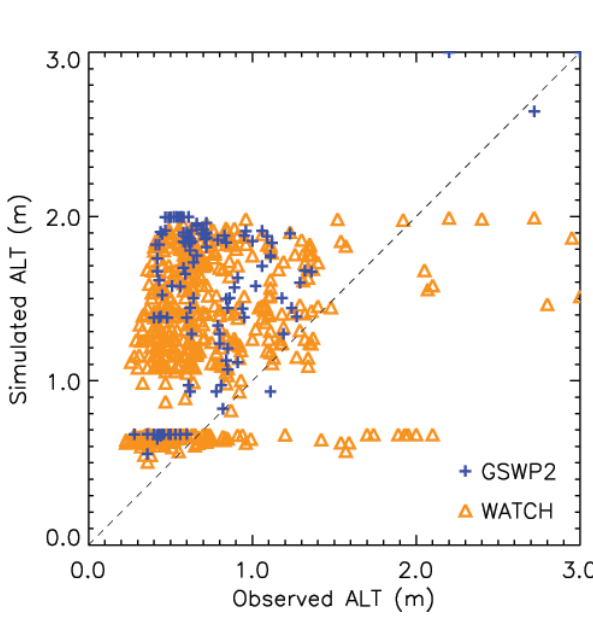
Fig. 2. Observed and simulated (calculated from soil temperature profiles) active layer thickness (ALT) at CALM observations sites. Values are shown for the period 1990–1995 for the JULES-GSWP2 run, and 1990–2000 for the JULES-WATCH run.